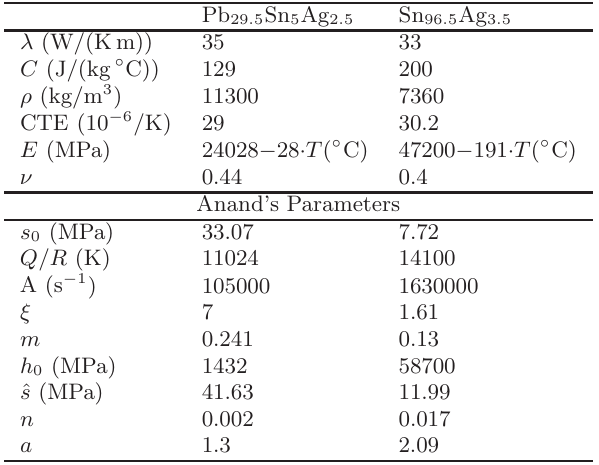
Table 4. Solders constitutive laws parameters